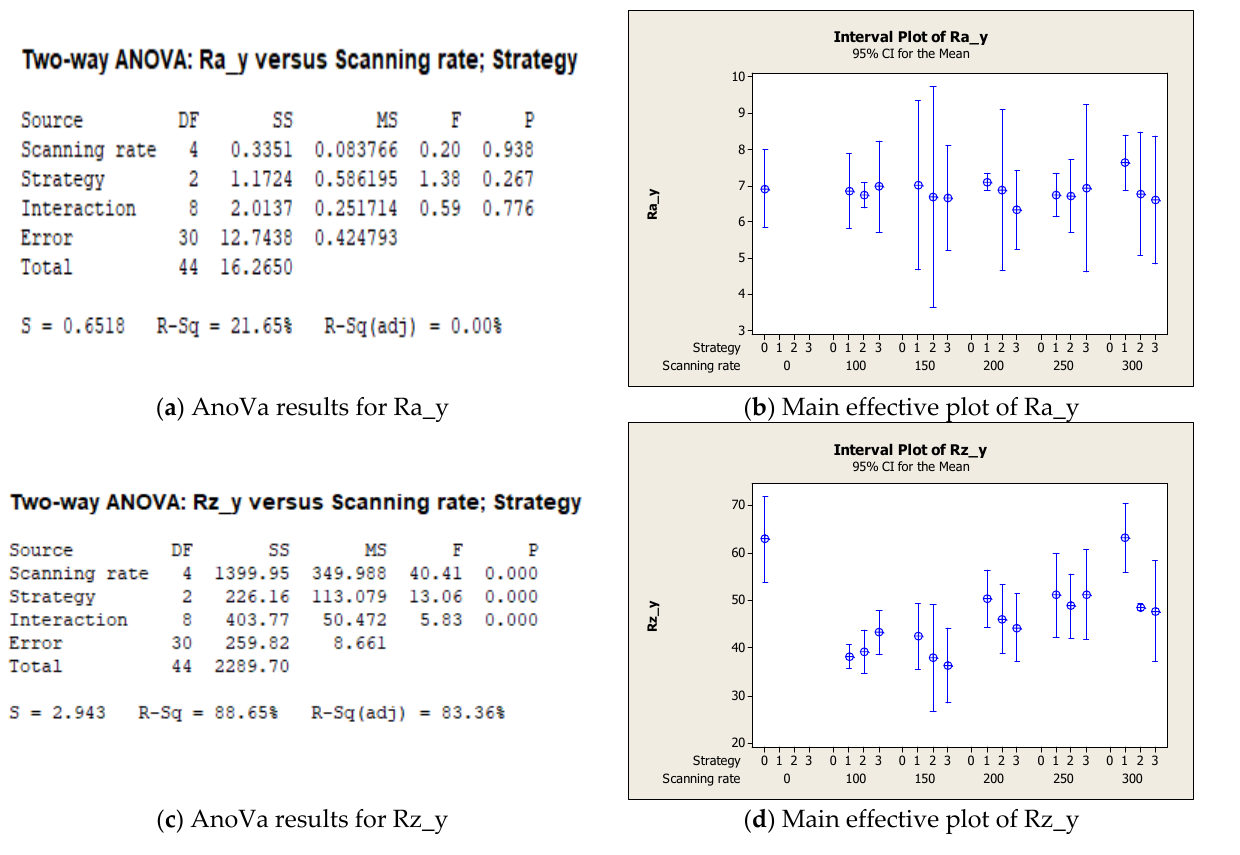
Figure 6. Main results of statistical analysis along the y direction. ( a ) AnoVa results for Ra_y; ( b ) Main effective plot of Ra_y; ( c ) AnoVa results for Rz_y; ( d ) Main effective plot of Rz_y.